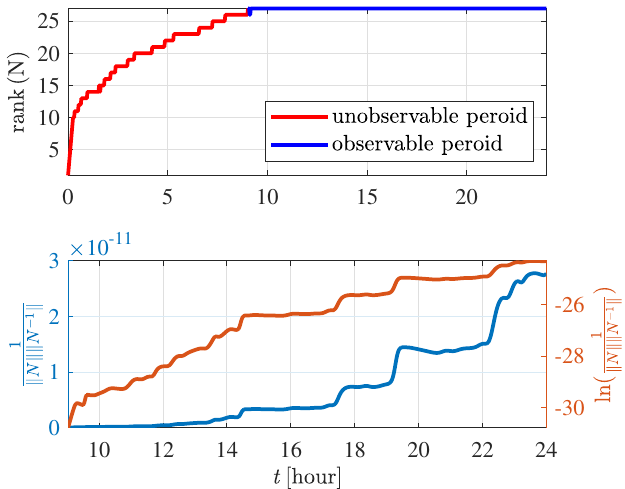
Figure 4. Observability analysis results of the sixth-order